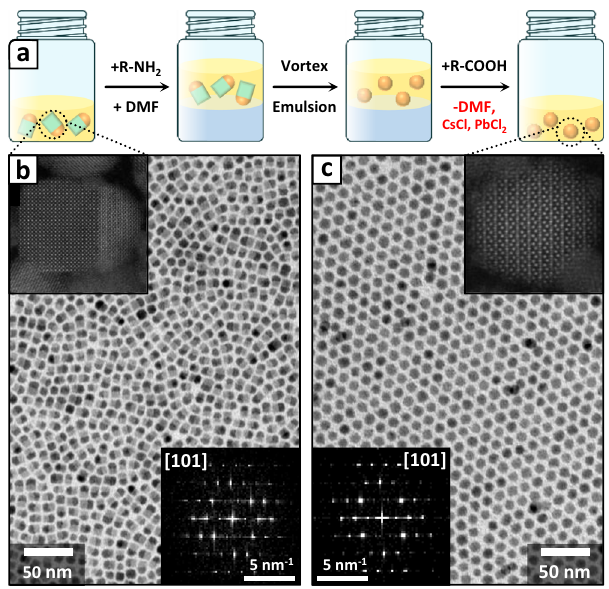
Fig. 4 Selective etching of Pb 4 S 3 Cl 2 /CsPbCl 3 heterostructures. a Scheme of the DMF-assisted etching procedure developed to transform the Pb 4 S 3 Cl 2 /CsPbCl 3 heterostructures into Pb 4 S 3 Cl 2 NCs in the presence of surfactants (R-NH 2 = oleylamine, R-COOH = oleic acid). The cyan cubes and the orange spheres represent the CsPbCl 3 and the Pb 4 S 3 Cl 2 domains of the heterostructures, respectively. b TEM image of the starting heterostructures. The top inset shows an HAADF-STEM image of one heterostructure prior to the etching, while the bottom inset shows the FFT of the chalcohalide domain of the same image. c TEM image of the etched NCs. The top inset shows an HAADF-STEM image of one NC after the etching, while the bottom inset shows the FFT of the same image. The two FFTs demonstrate that the Pb 4 S 3 Cl 2 domains retain the same crystal structure before and after the etching